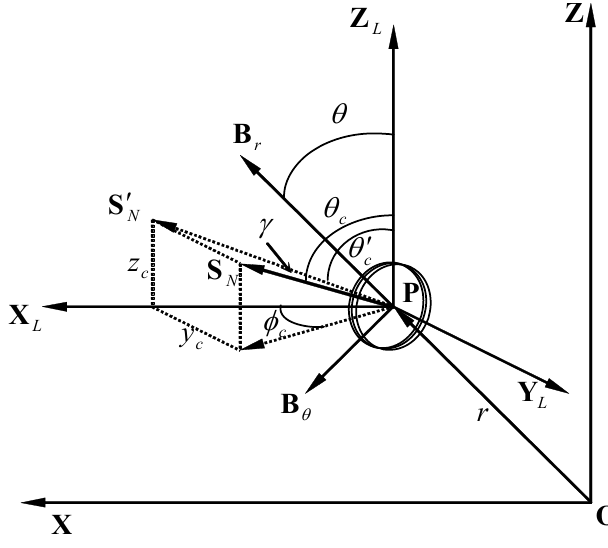
Figure 2. The coil at position P with the orientation pointed by unit vector S from